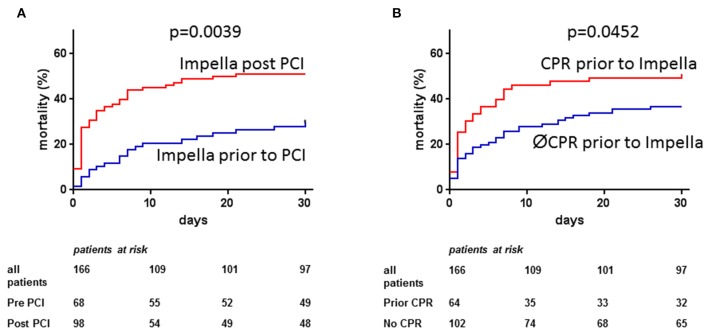
Observed 30-day mortality in acute myocardial infarction cardiogenic shock (AMI-CS) on Impella: Observed 30-days mortality in AMI-CS treated with Impella was lower if implantation was performed prior to percutaneous coronary intervention (PCI, A) and higher in patients with cardiac arrest prior to Impella implantation (B).